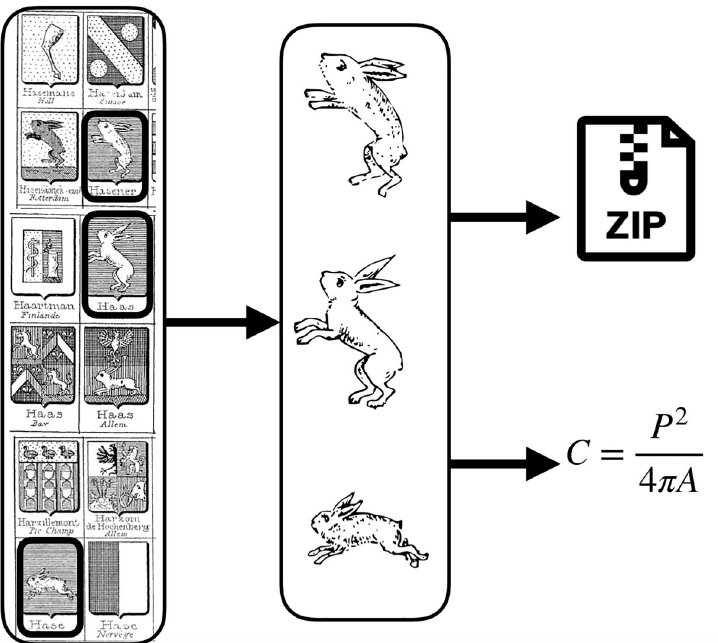
Fig 1. Visual complexity metrics derivation. Our complexity measures were obtained in the following way: (1) three arms were selected for each motif from our reference armorial [56], (2) pictures of shields were edited to obtain a picture of the motif on its own, (3) the edited pictures went through the Potrace algorithm to improve their quality (through vectorization), (4) they were zipped and the zip file’s size served as our measure of descriptive complexity, while their perimetric complexity was calculated using Mathematica. Finally, all the three measures from the three pictures obtained for each motif were averaged to get one reliable measure for each type of complexity for each motif in our inventory.